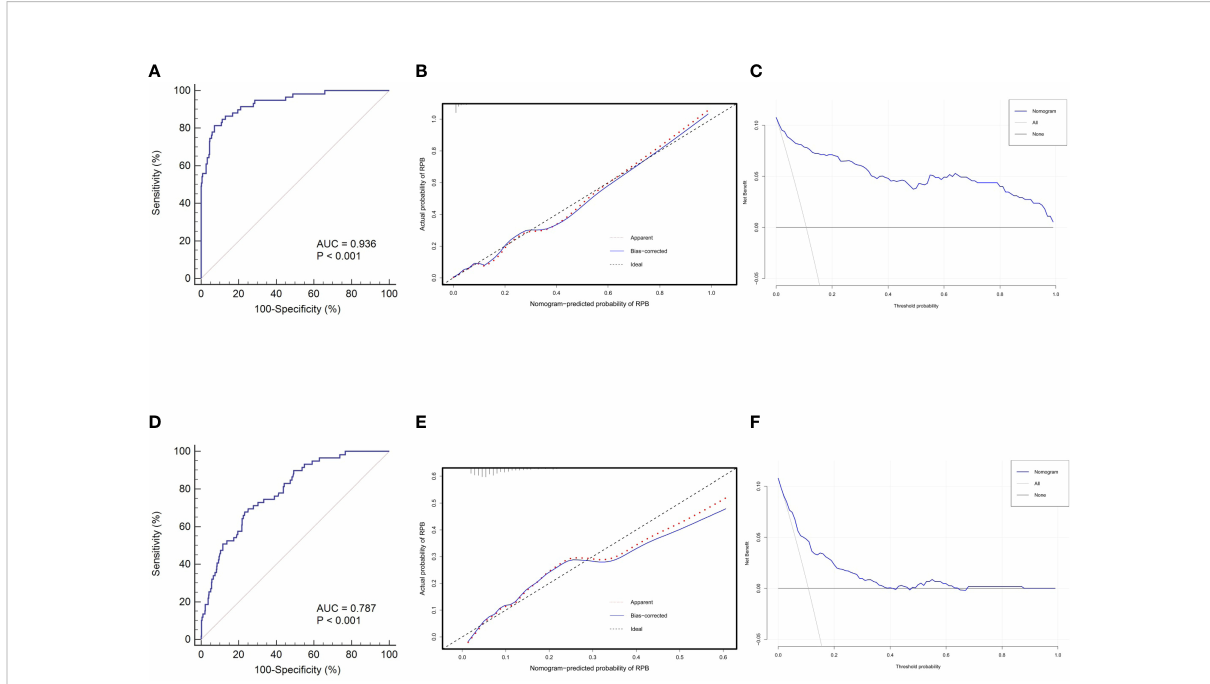
FIGURE 5 Nomogram validations in different cohorts. The ROC curve (A) , calibration plot (B) and DCA curve (C) reveal favorable discrimination, calibration and clinical net bene fi t in the training cohort. In the validation cohort, this model still shows acceptable discrimination (D) , calibration (E) , and clinical utility (F) , albeit with lower power than the training cohort. ROC, receiver operating characteristic; AUC,area under the curve; DCA, decision curve analysis.